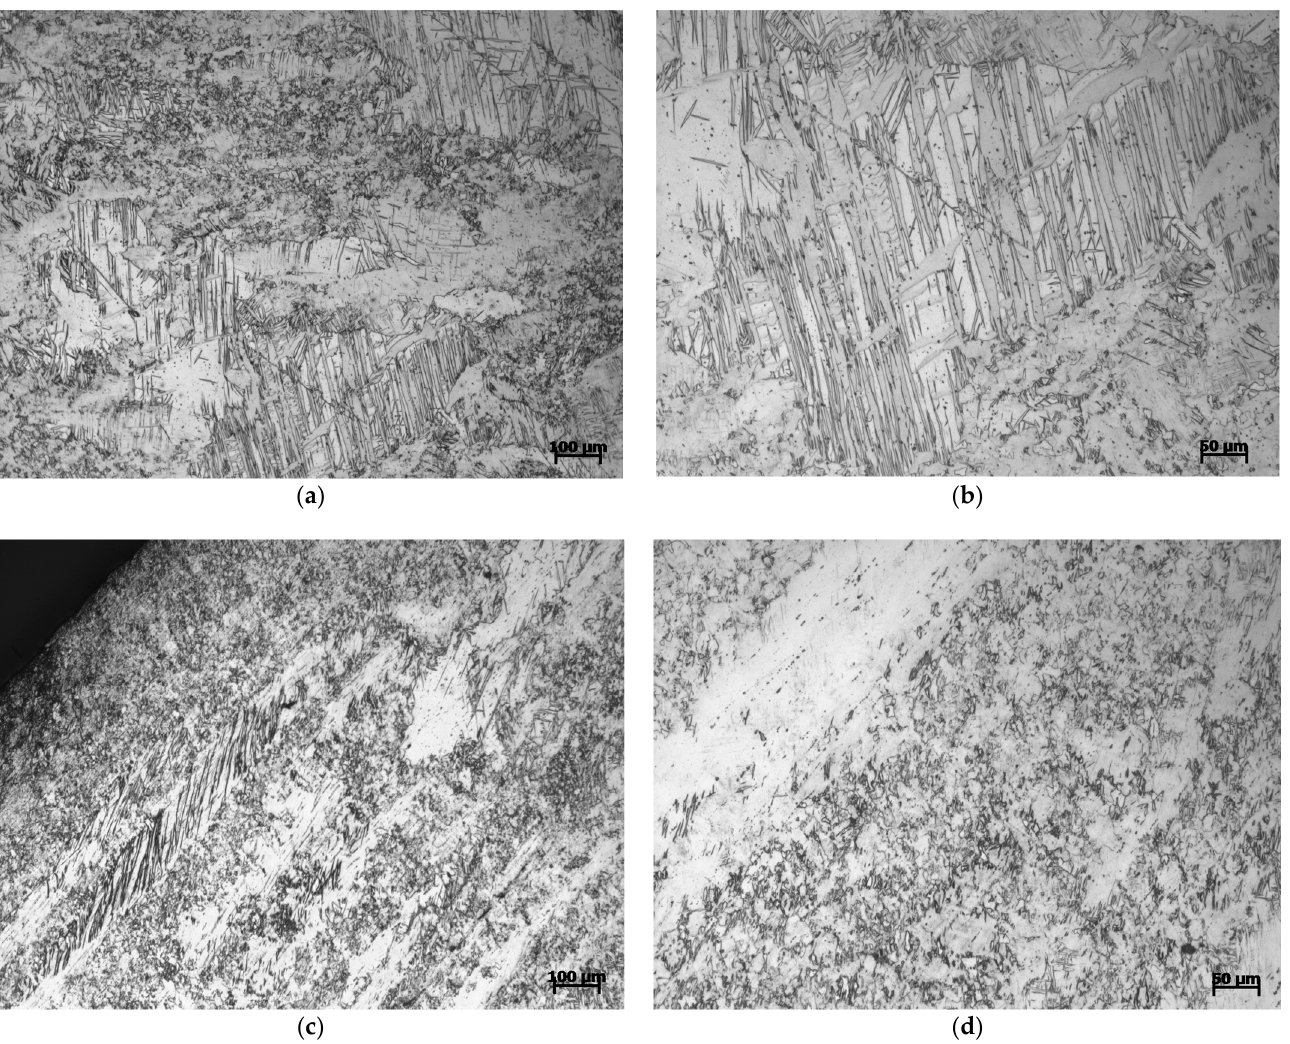
Figure 12. Microstructure of Mg-Al-Ca-Mn alloy compressed in the vertical 45° direction under ( a,b ) 700/s strain rate and ( c,d ) 1400/s strain rate.